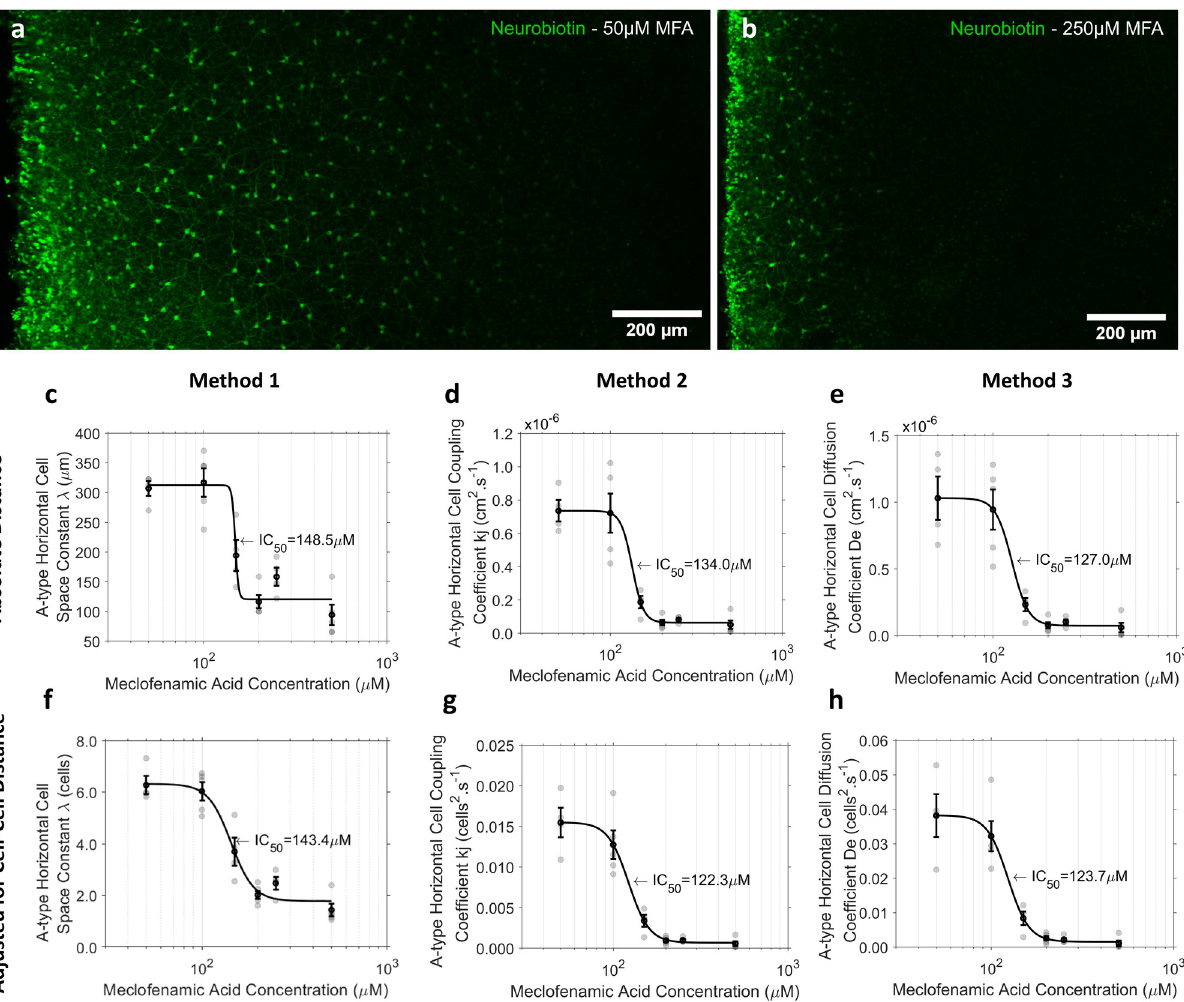
Fig 7. Comparison of three analytical methods for describing dose-response data for a-type horizontal cell (aHC) coupling and meclofenamic acid (MFA) concentration in vitro . The relative diffusion of Neurobiotin TM through HCs in tissue incubated in (a) 50 μ M MFA and (b) 250 μ M MFA. Column 1 (c, f) contains data analysed using Method 1, column 2 (d, g) shows the same data analysed using Method 2 and column 3 (c, f, i) shows the same data analysed using Method 3. The first row of plots (c, d, e) contains the mean ± SE (black marker, black error bars) and individual measurements (grey markers) for each measure of cell-coupling obtained via Methods: (c) 1, (d) 2 and (e) 3. Row 2 (f, g, h) contains the mean ± SE (black marker, black error bars) and individual measurements (grey markers) for each measure of cell-coupling normalised to the mean cell-cell spacing between adjacent aHCs, obtained via Methods (f) 1, (g) 2 and (h) 3.